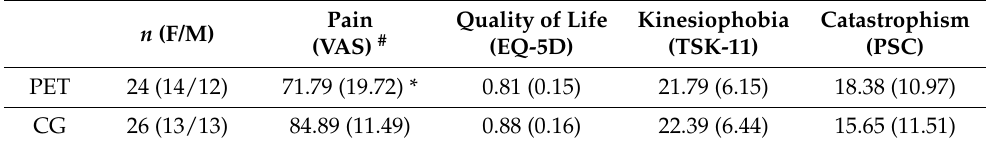
Table 3. Summary of descriptive statistics (mean and standard deviation) of outcomes measured in both groups (PET and CG) after six months of